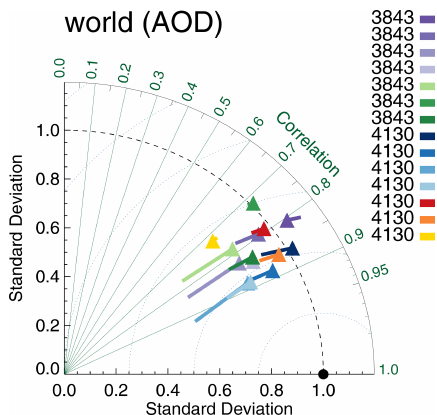
Figure 19. Taylor diagram for satellite products evaluated with AERONET. Symbols indicate correlation and internal variability relative to AERONET; the line extending from the symbol indi- cates the (normalized) bias (see also Sect. 3.1). Colours indicate the satellite product (see also Fig. 1); numbers next to coloured blocks indicate the amount of collocated data. All morning products were collocated together with AERONET (Kinne et al., 2013, selection, pruned) within 3h, similar for all afternoon